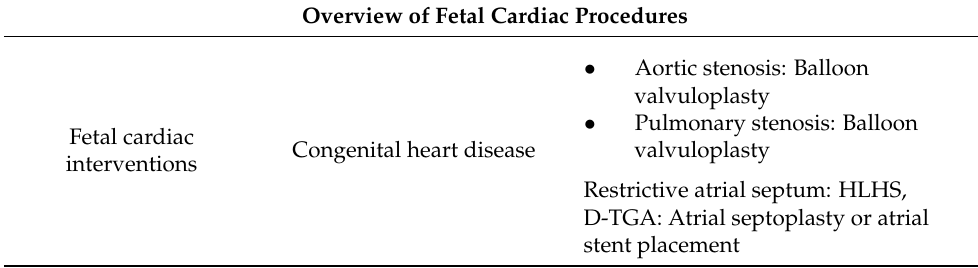
Table 1. An overview of fetal cardiac